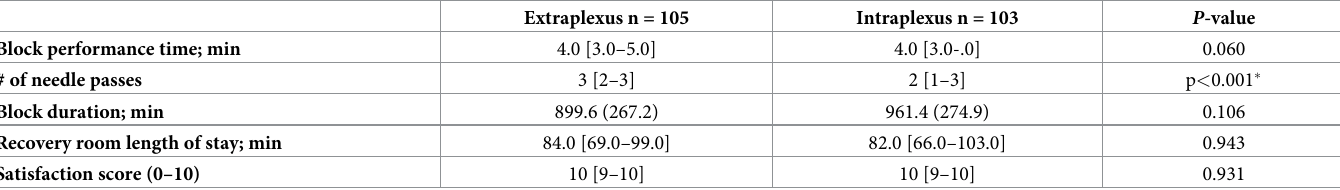
Table 3. Block characteristics and efficacy outcomes.